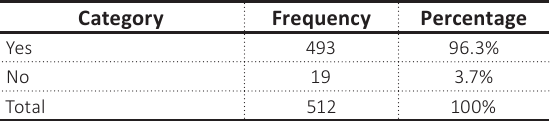
Table 1. Frequency distribution of the study